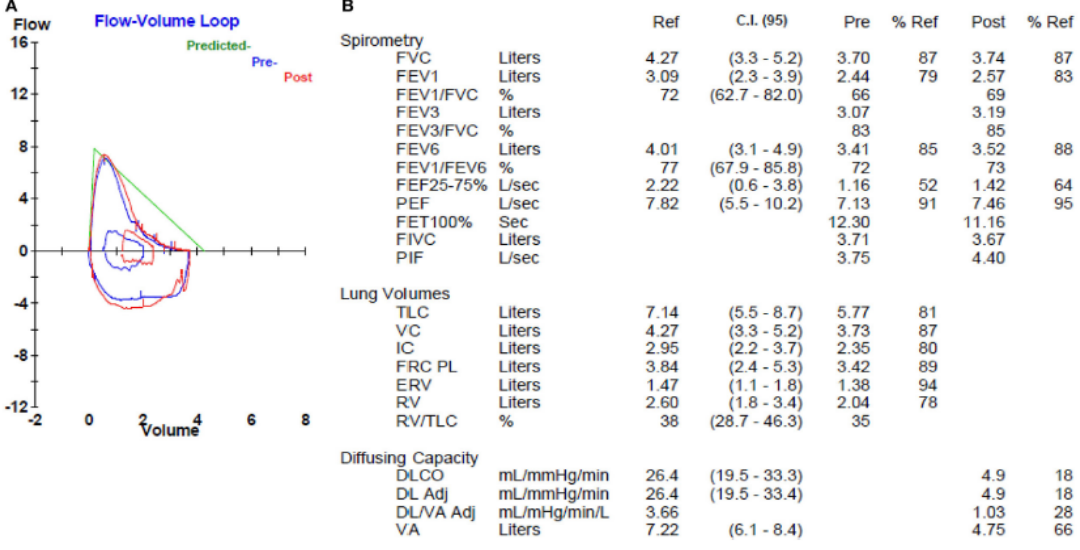
Figure 1. Pulmonary function test in a patient with combined pulmonary fibrosis and emphysema. The flow-volume loop ( A ) shows a mild obstructive morphology but normal spirometry ( B ). Lung volumes ( B ) are normal. The diffusing capacity (DL) ( B ) is markedly reduced. C.I. (95): 95% confidence interval; FVC: forced vital capacity; FEV 1 : forced expiratory volume in the first second;